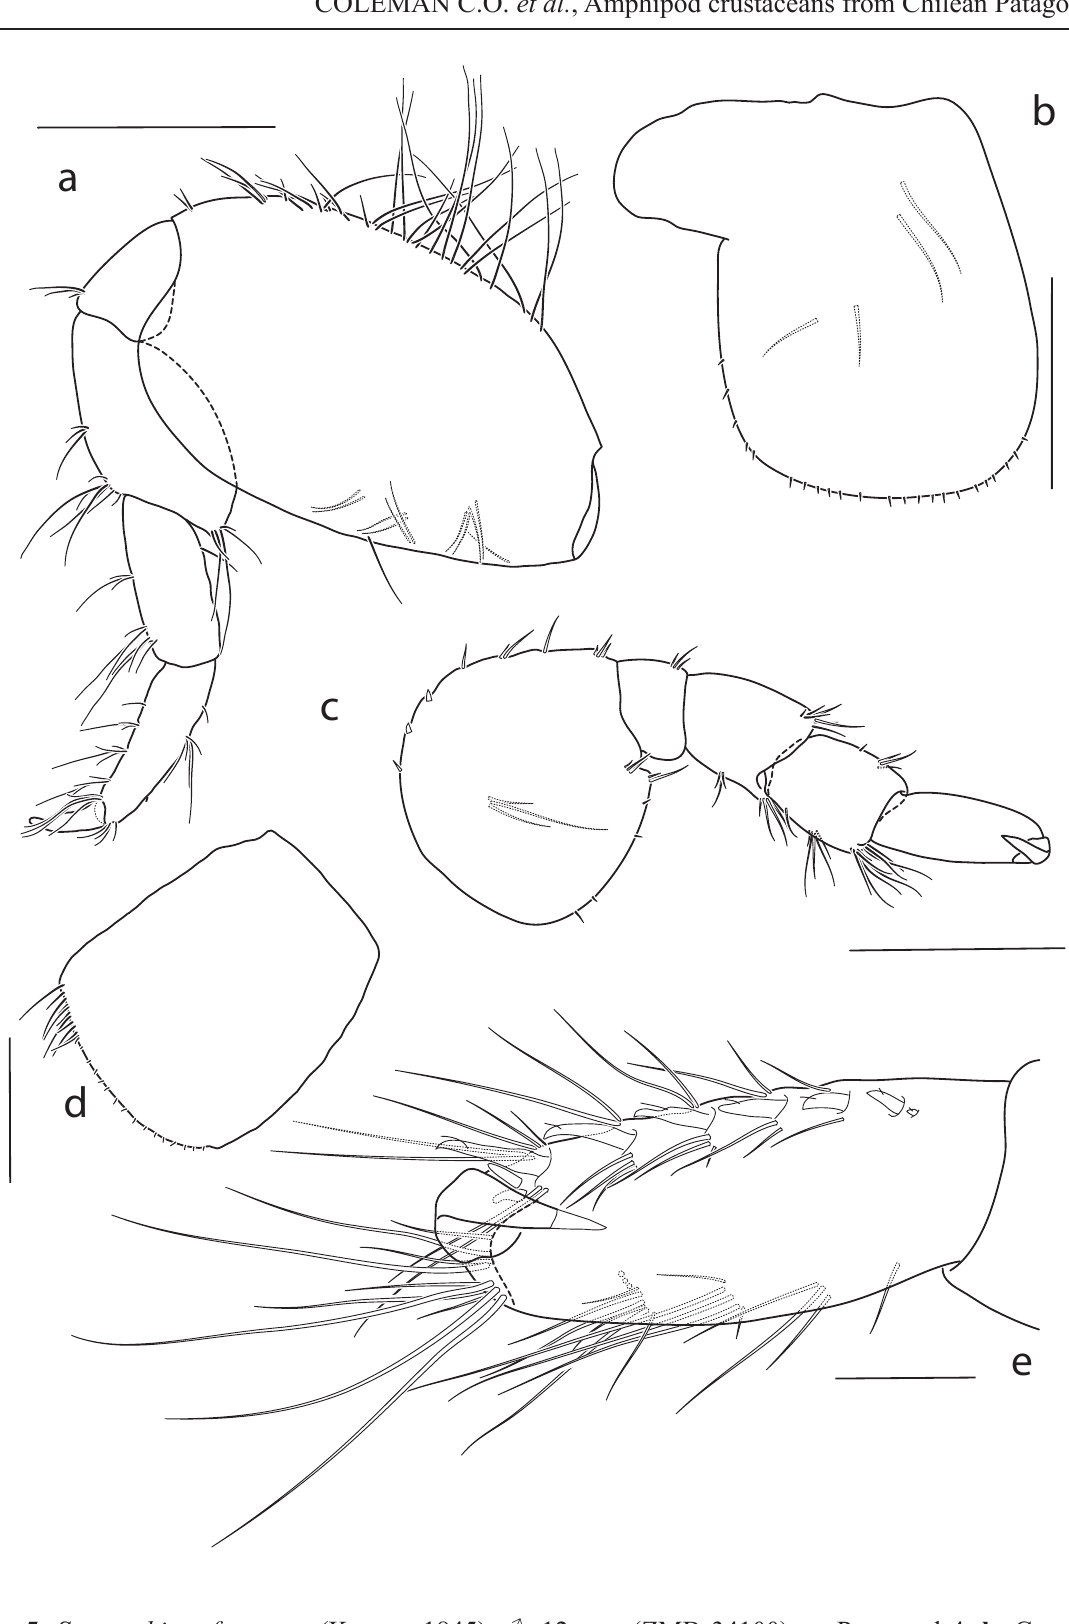
Fig. 5. Sunamphitoe femorata (Krøyer, 1845), ♂, 12 mm (ZMB 34100). a . Pereopod 4. b . Coxa 5. c . Pereopod 5. d . Coxa 4. e . Propodus and dactylus of pereopod 5. Scale bars: a, d = 500 µm; b = 100 µm; c = 1 mm; e = 200